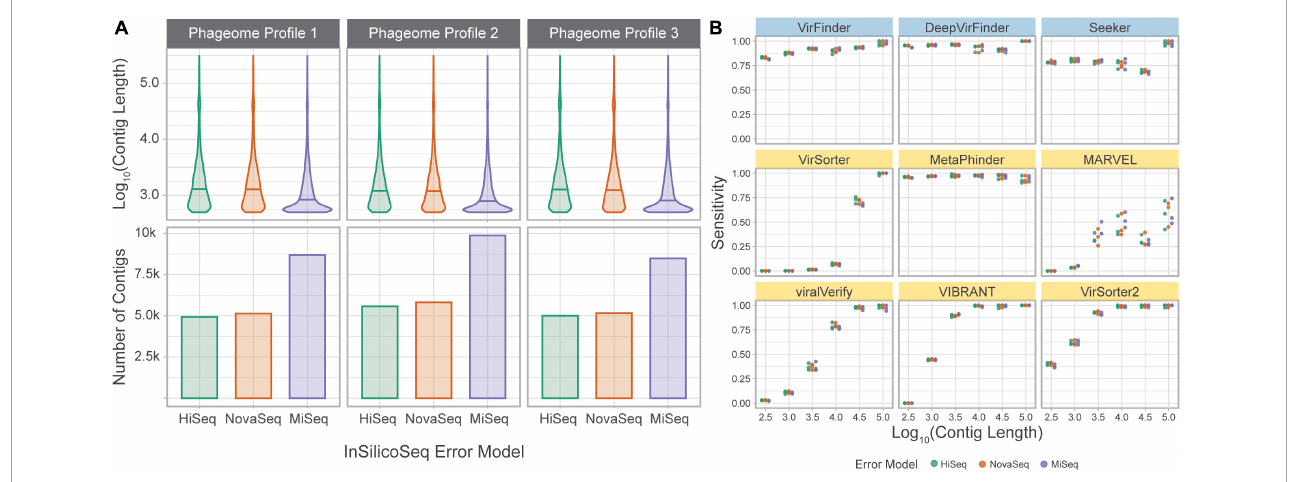
FIGURE6 Tools performances on a simulated phageome dataset. (A) Length distributions, and number of, assembled contigs constituting the nine phageomes generated using the three phageome profiles and three error models. (B) Sensitivity of classifying simulated phage contigs. Contigs were grouped by length ( x -axis) for computation of sensitivity. Error models are ordered by increasing read length. Top row of tools are sequence-based (in blue), bottom two rows are homology-based (in yellow).